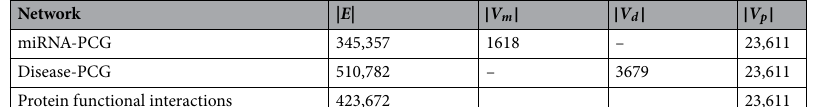
Table 10. Statistics for the side data sources. | E | denotes the number of interactions/associations. | V m | , | V d | , | V p | represent the number of miRNAs, diseases, and PCGs, respectively.